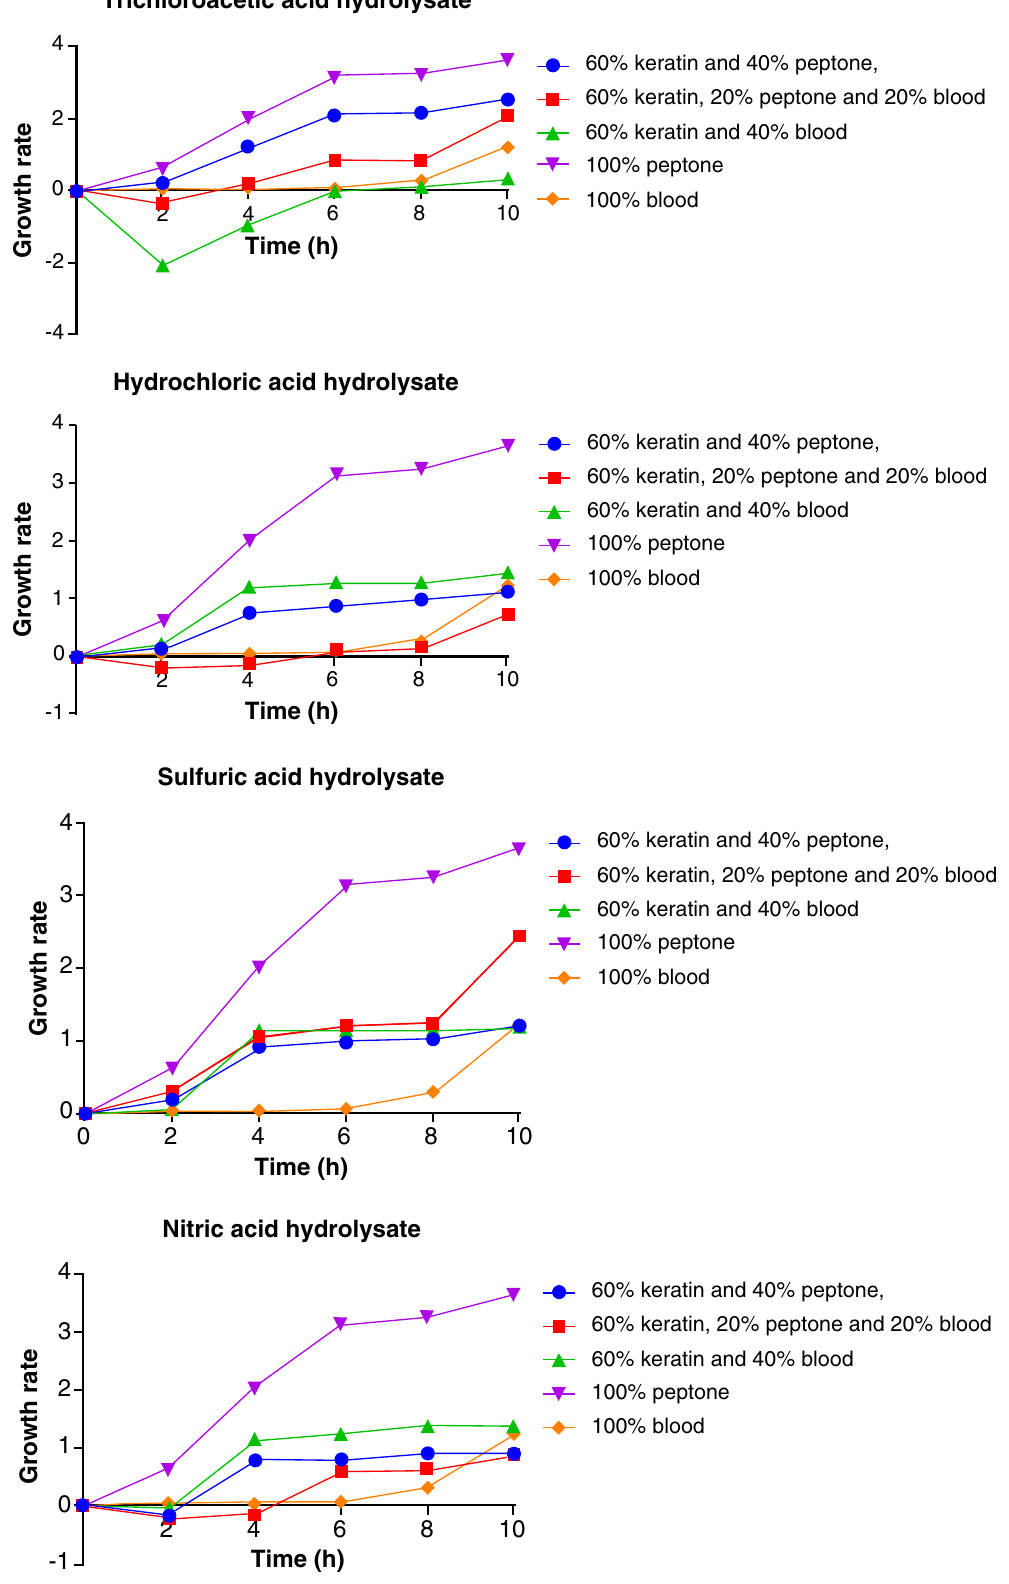
SO and HNO 2 4 3